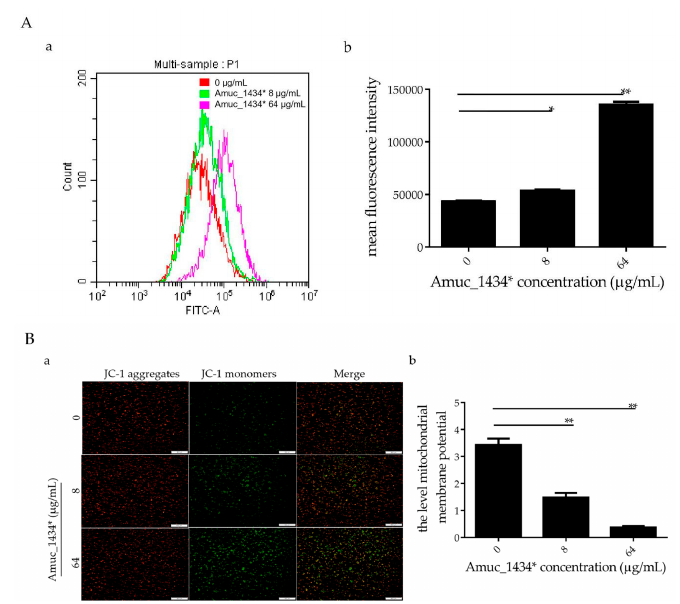
Figure 4. Amuc_1434* promoted a change of cellular redox status and mitochondrial dysfunction in LS174T cells. LS174T cells were treated with the indicated concentrations of Amuc_1434* for 24 h. ( A ) Reactive oxygen species (ROS) production was examined by flow cytometric analysis ( a ) with 2,7-Dichlorodi-hydrofluorescein diacetate (DCFH-DA) staining, ( b ) mean fluorescence intensity of ROS for DCFH-DA. Data are expressed as the mean ± standard deviation of three separate experiments, *: p < 0.05; **: p < 0.01. ( B ) Mitochondrial membrane potential ( ∆ ψ ) was detected by fluorescence microscopy using JC-1 staining. ( a ) Fluorescent micrographs of mitochondrial membrane potential obtained in Amuc_1434*-treated LS174T cells at 24 h, bar = 500 µ m; ( b ) Quantification of relative fluorescent intensity per cell determined by Image J software. Values represent as ratio of red to green fluorescence (**: p < 0.01, n = 3). Data are mean ±